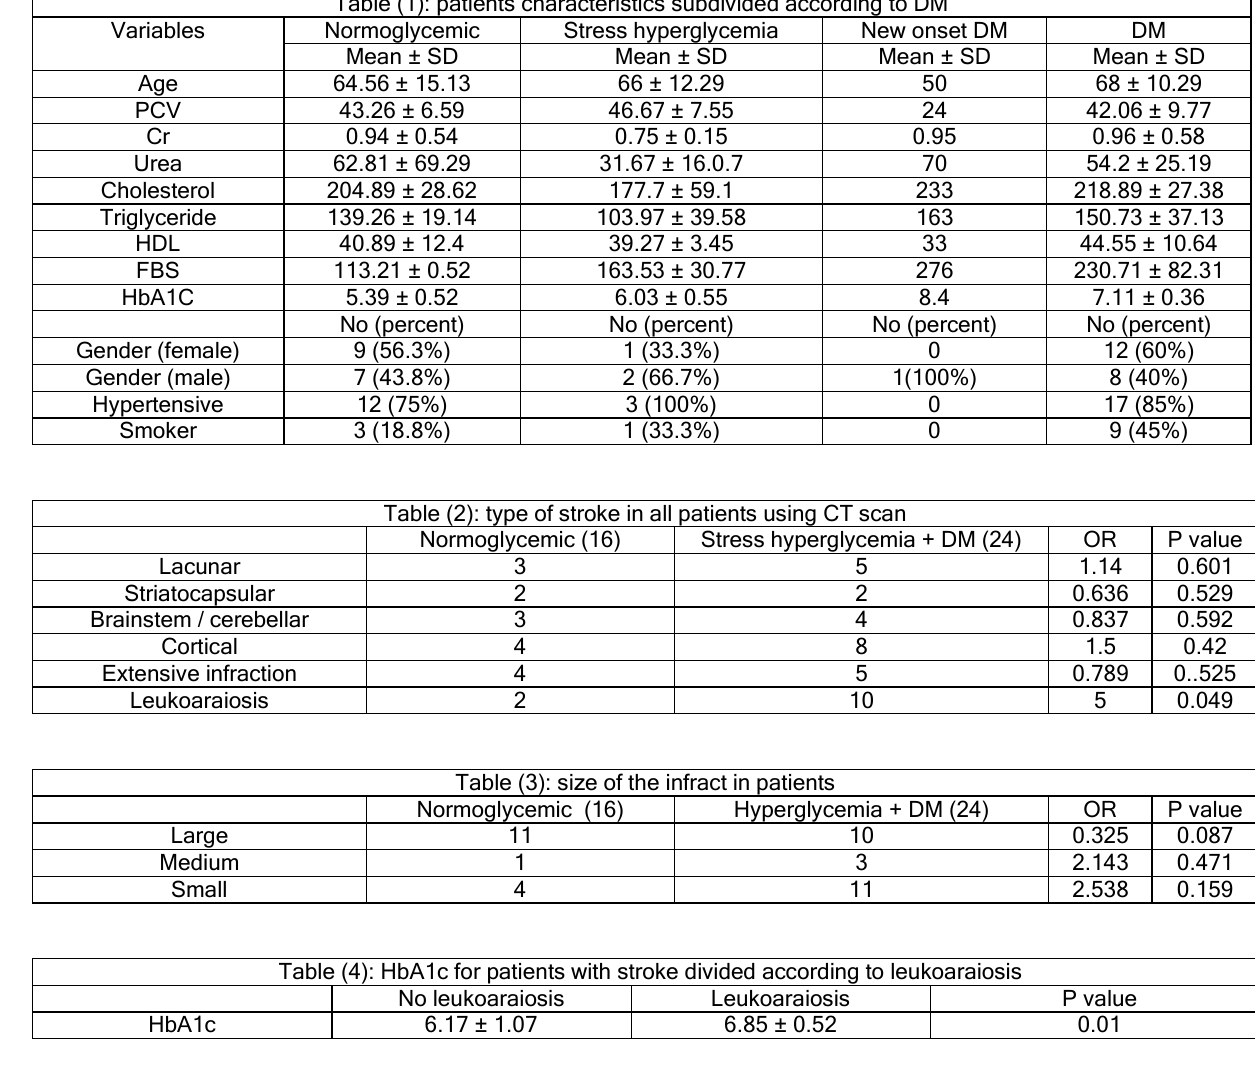
Table (1): patients characteristics subdivided according to DM